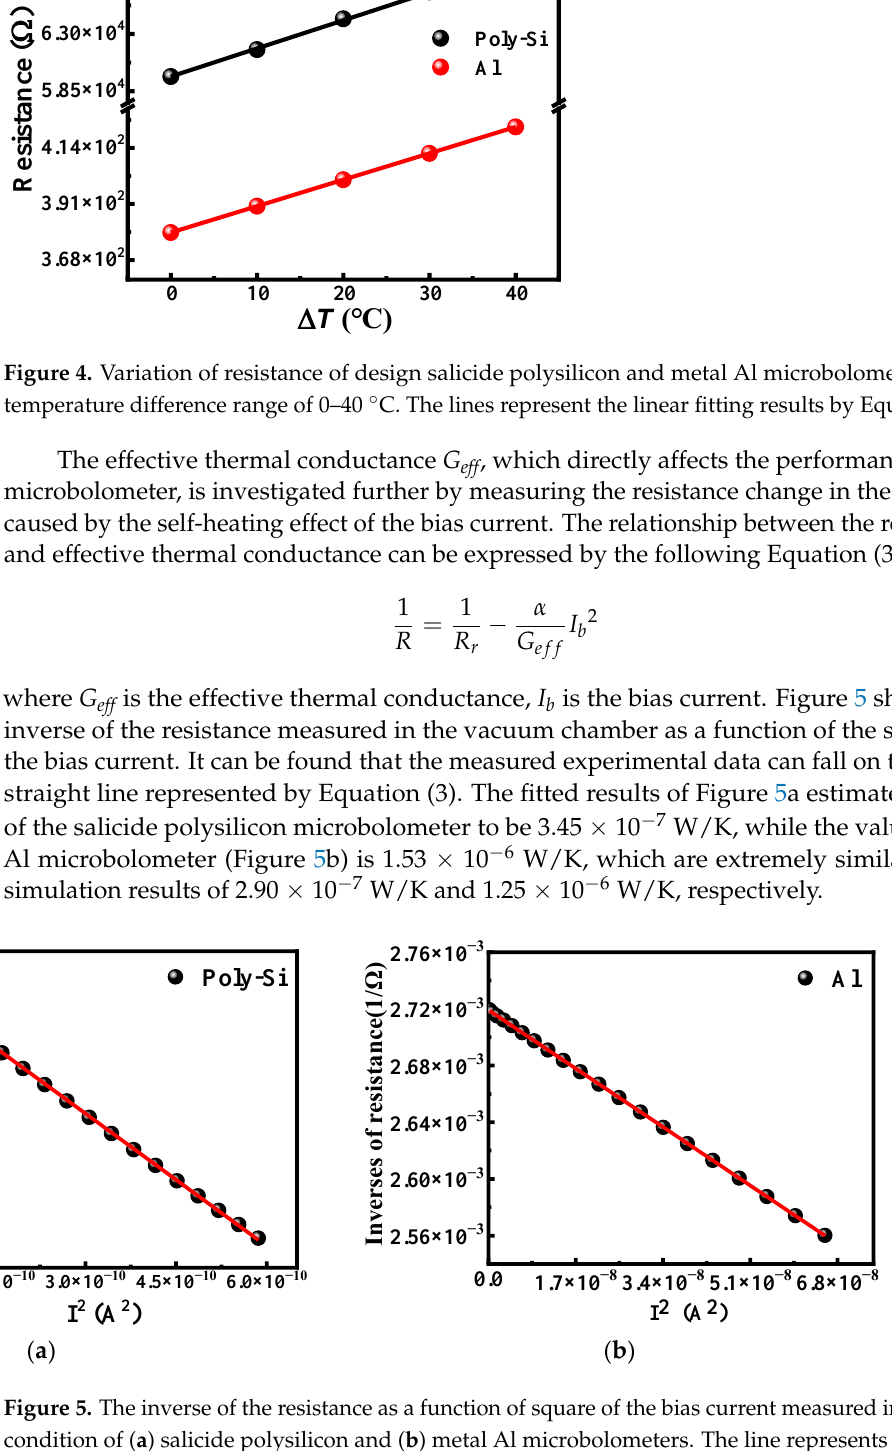
Figure 5. The inverse of the resistance as a function of square of the bias current measured in vacuum condition of ( a ) salicide polysilicon and ( b ) metal Al microbolometers. The line represents the linear fitting by Equation (3).